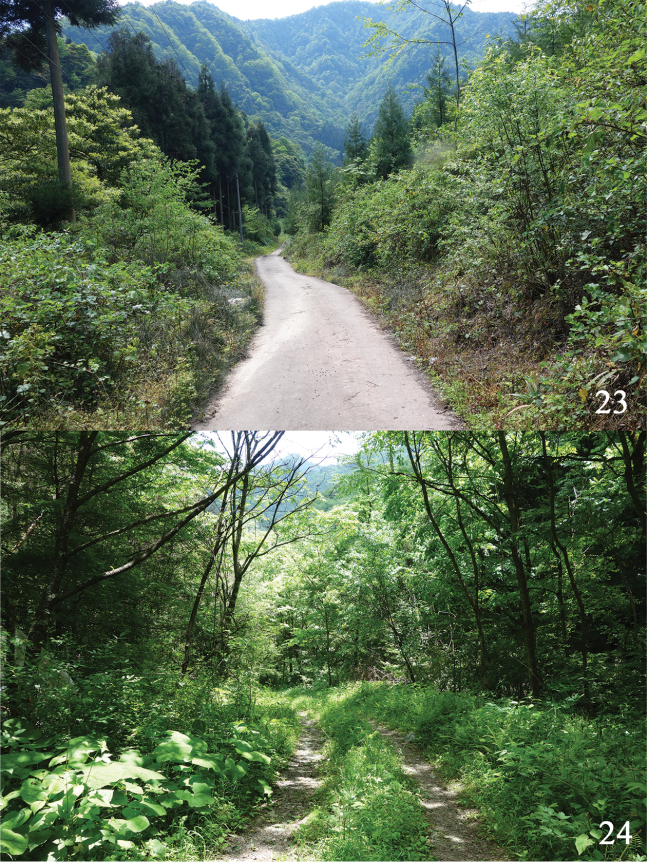
Habitats of Psychostrophia
nymphidiaria23 Mt Niba, Yingjing County 22 Shennongjia, Yichang City.